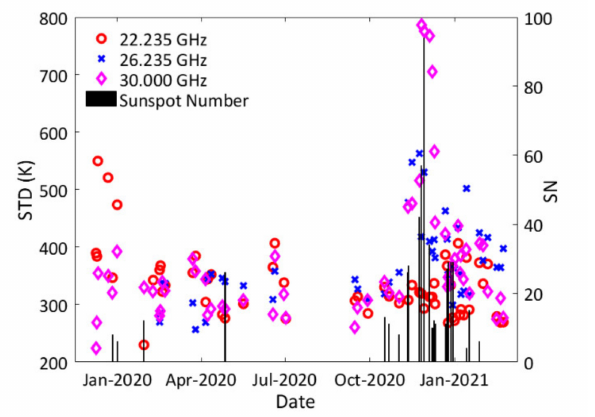
Figure 16. The correlation between the daily standard deviation (STD) of the solar TB and the sunspot numbers (SN) (Source: WDC-SILSO, Royal Observatory of Belgium,